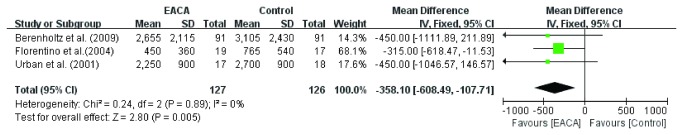
The weighted mean difference (WMD) estimate for blood transfusion.